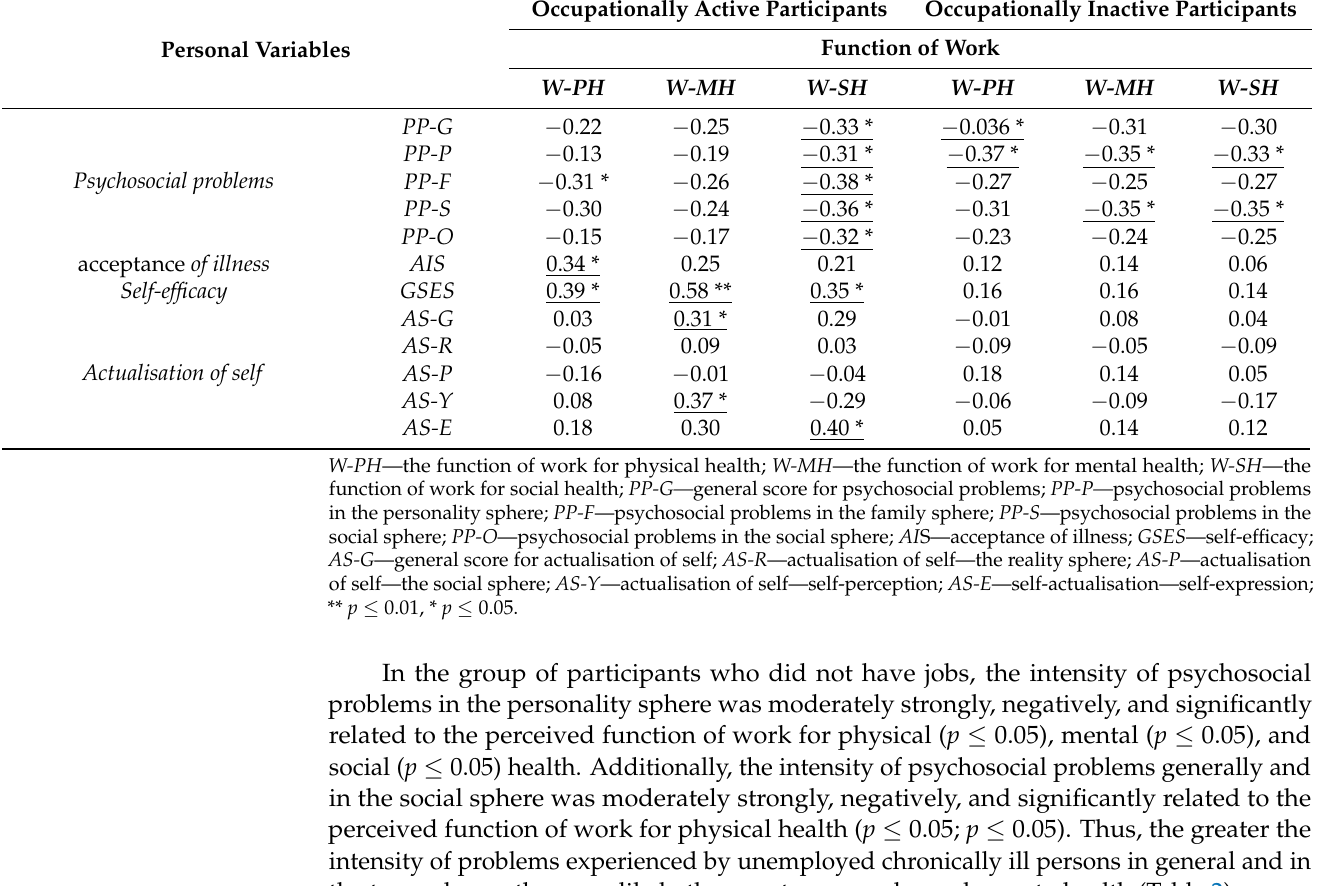
Table 2. Relationships between variables representing the individual characteristics of the occupa- tionally active and inactive participants and the perceived function of work for health